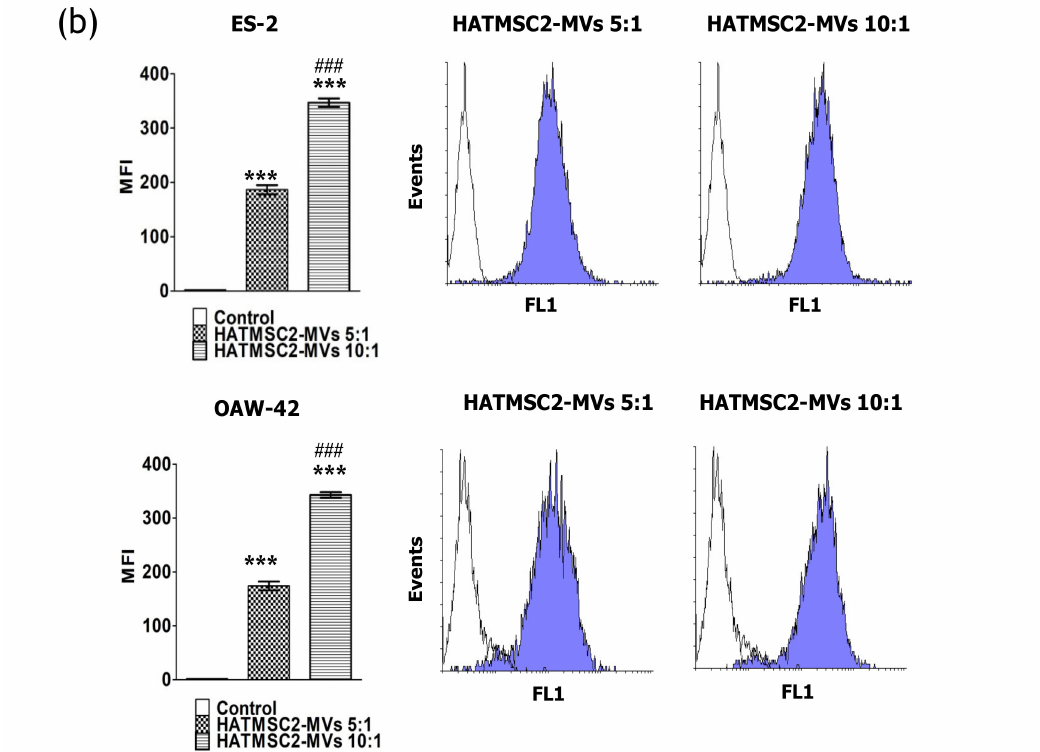
Figure3. InternalizationofHATMSC2-MVsintoovariancancercells. ( a )Imagesfromthree-dimensional microscopic analysis of HATMSC2-MV internalization into ES-2 and OAW-42 cells at di ff erent ratios. The images were taken using an inverted microscope after 24 h of incubation with fluorescently-labeled HATMSC2-MVs (scale bar: 20 µ m). A set of representative orthogonal slices is shown. Each image in a group consists of a large middle segment that represents the midpoint of the Z-stack in the xy plane; a narrow top segment that represents the xz plane; and a narrow segment on the right that represents the yz plane. The arrows point to MVs that have been taken up into the cell. ( b ) Bottom left panel, the bar graph represents the mean fluorescence intensity (MFI) of ES-2 cells treated with fluorescently labeled HATMSC2-MVs at di ff erent ratios. Untreated cells without MVs served as a control. Right panel, flow cytometry analysis of HATMSC2-MV internalization. Empty histograms represent the control for untreated cells, and blue filled histograms show the green fluorescence of ovarian cancer cells ES-2 and OAW-42 after HATMSC2-MV internalization at di ff erent ratios. The data represent mean ± SEM values from three independent experiments performed in duplicate. *** p < 0.001 calculated vs. control, ### p < 0.001 calculated vs. The HATMSC2-MVs 5:1 treatment. HATMSC2-MVs—microvesicles derived from immortalized human mesenchymal stem cells of adipose tissue